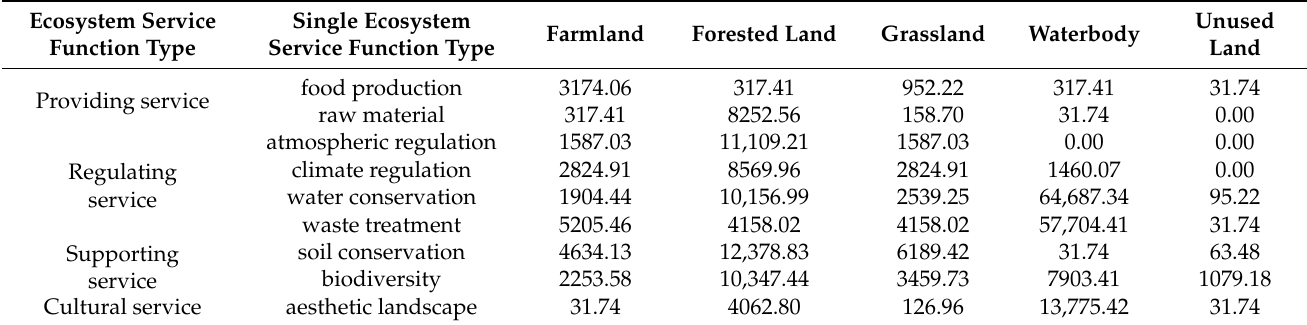
Table 1. Coefficients of ESV per unit area in Guangxi.